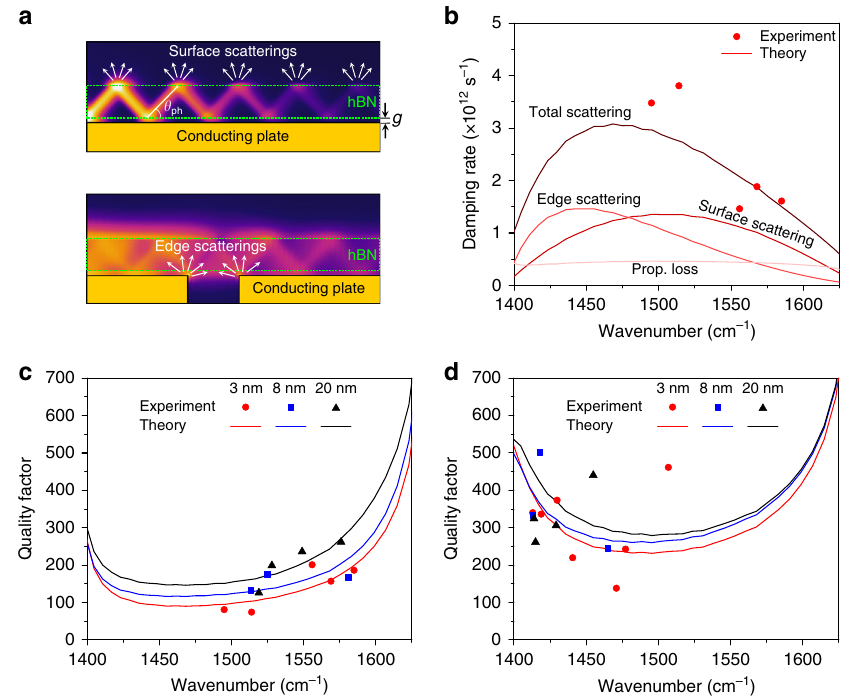
Fig. 5 Loss mechanism for hyperbolic image polaritons in h 10 BN. a Schematic illustration for the surface scatterings mediated by the hyperbolic rays inside hBN. b The loss contributions from three different damping mechanisms calculated using the analytical model in Eq. (1) for g = 3 nm. The red circles are the total scattering rates measured from the samples with different periodicities. The experimental (symbols) and analytical results (solid lines) for the quality factors obtained from the resonances for c the symmetric mode and d antisymmetric